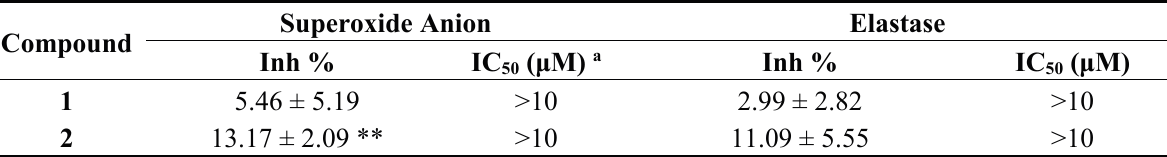
Table 2. Effects of compounds 1 and 2 on superoxide anion generation and elastase release in FMLP/CB-induced human neutrophils.